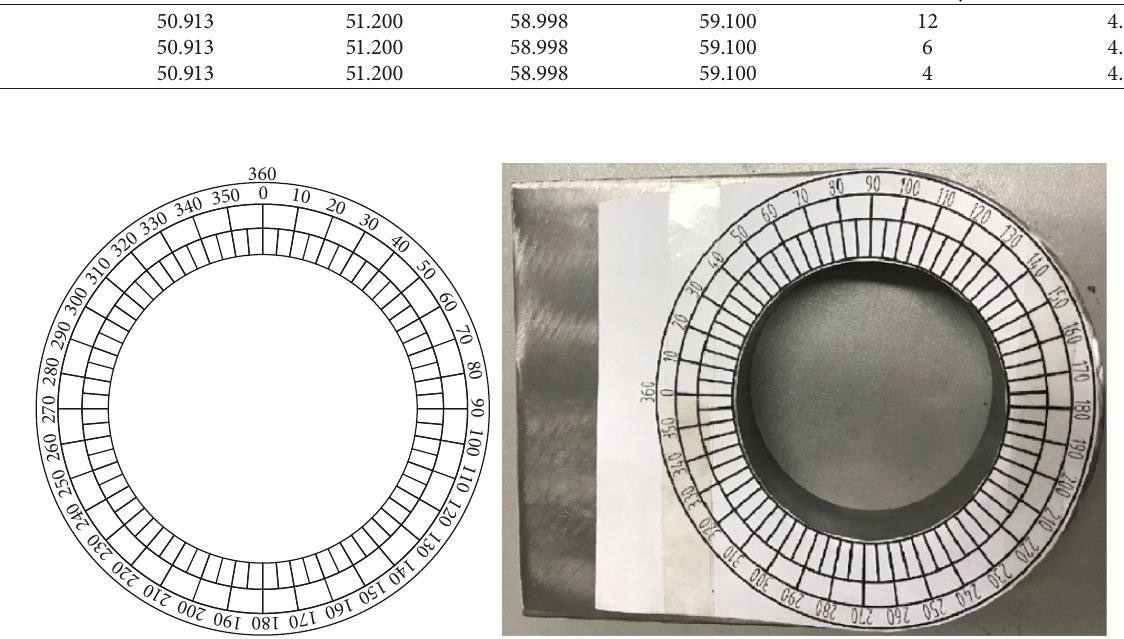
Figure 9: Scale plate on the